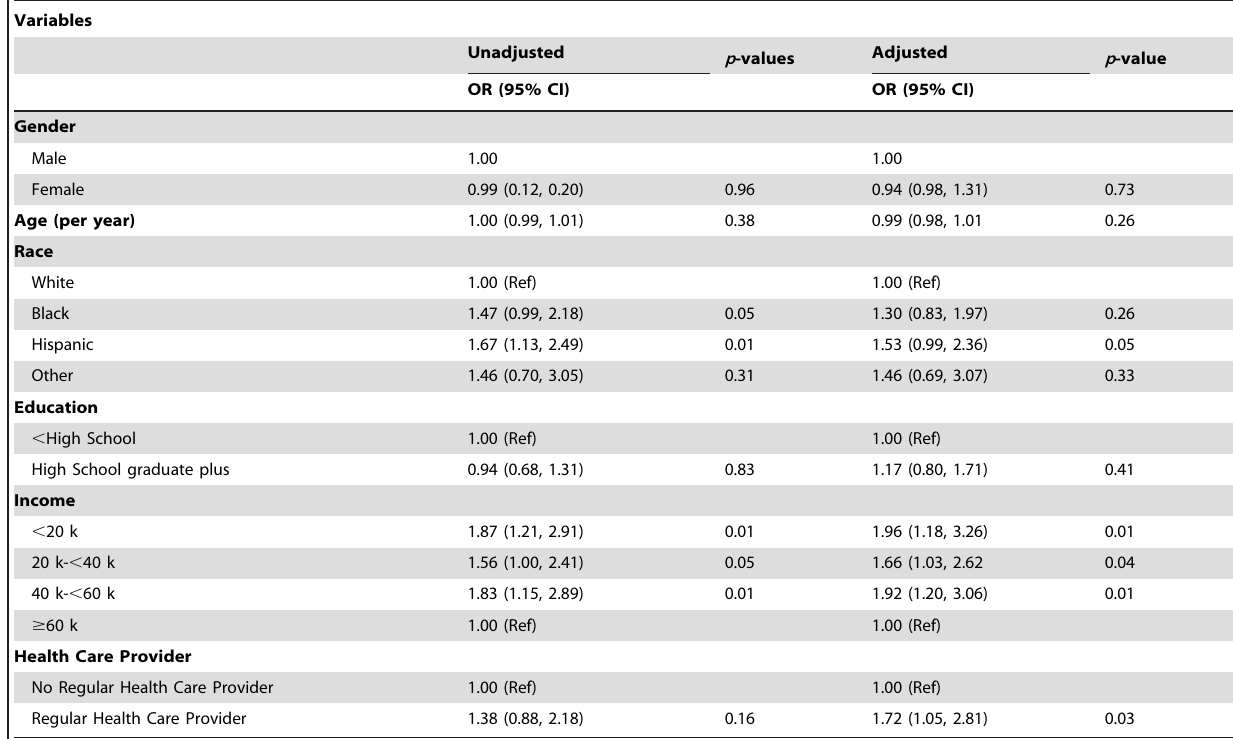
Table 3. Logistic Regression Analysis for Factors associated with having a previous